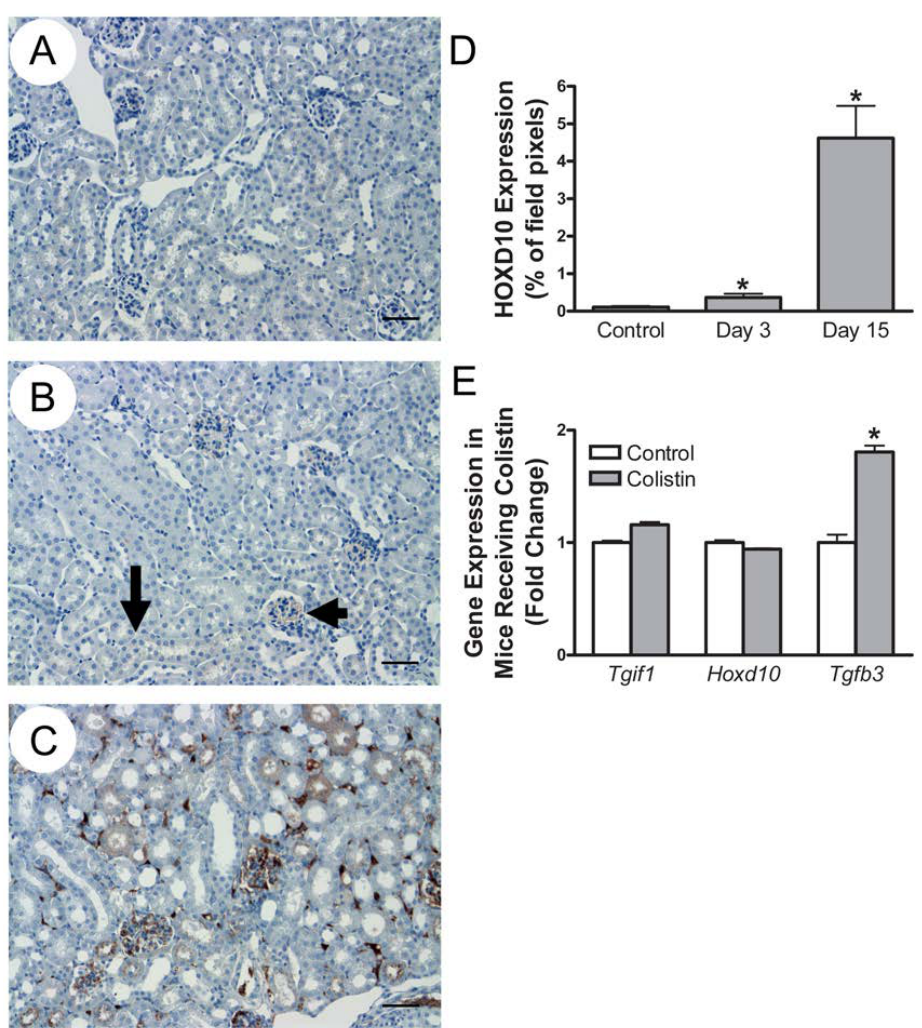
Figure 4. Homeobox protein D10 expression is increased in mouse kidney following colistin